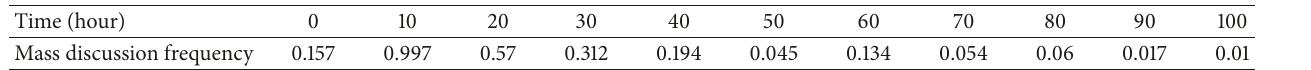
Table 5: Table function of mass discussion frequency.